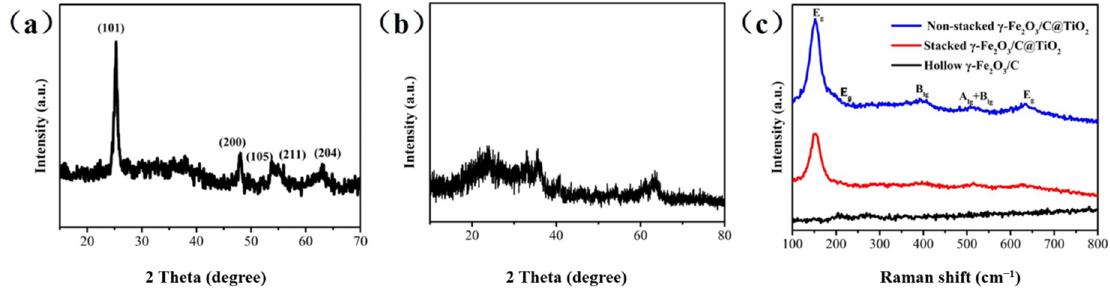
Figure 2. XRD patterns of non-stacked γ -Fe 2 O 3 /C@TiO 2 ( a ) and hollow γ -Fe 2 O 3 /C ( b ); Raman spectra ( c ) of non-stacked γ -Fe 2 O 3 /C@TiO 2 , stacked γ -Fe 2 O 3 /C@TiO 2 , and hollow γ -Fe 2 O 3 /C.